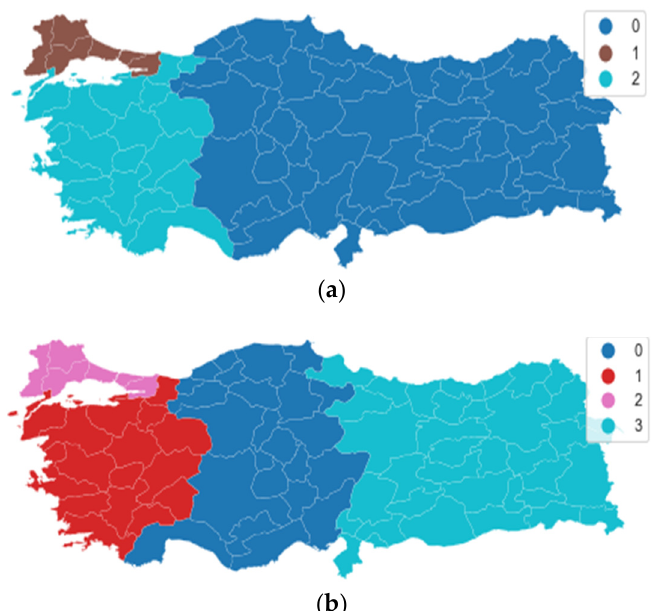
Figure 5. ( a ) Three-means clustering of 24-h locational prices. ( b ) Four-means clustering of 24-h locational prices.